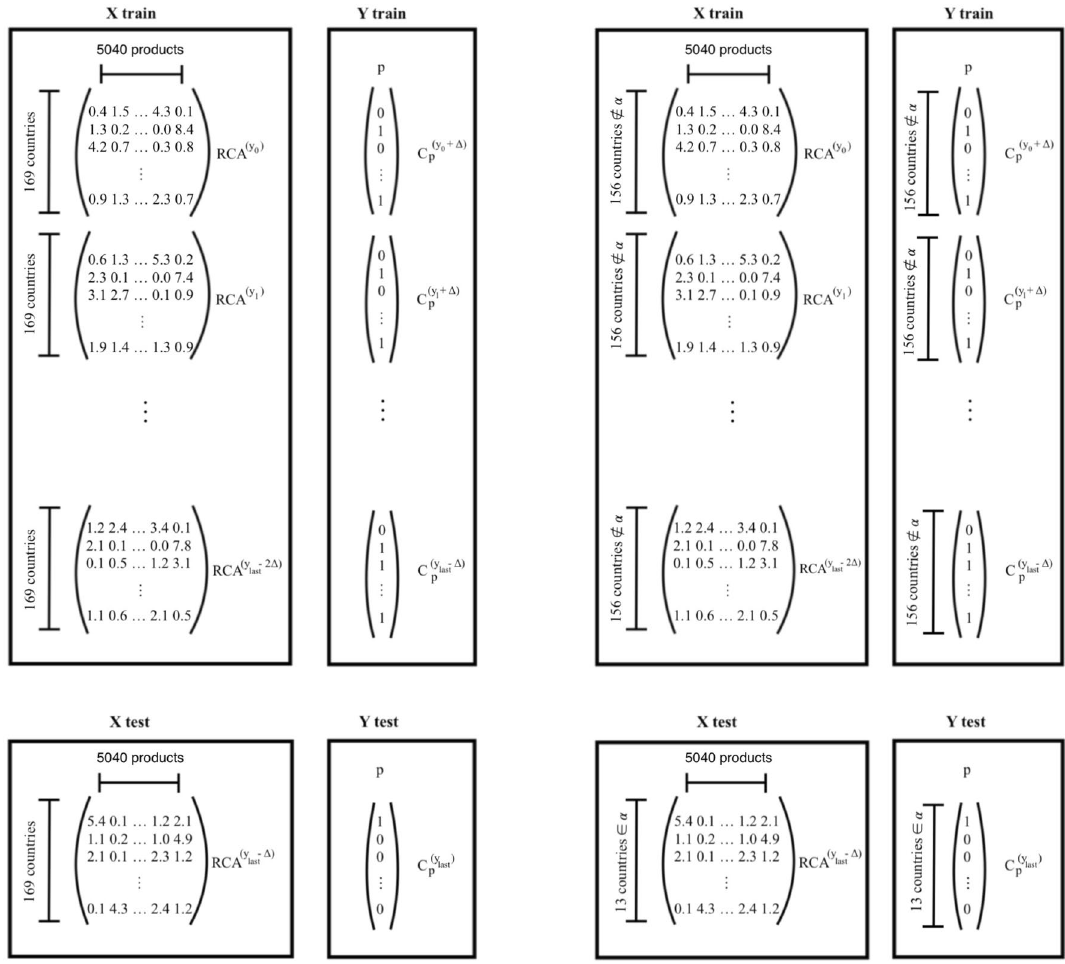
Figure 10. The training and testing procedure with (right) and without (left) cross validation. See the text for a detailed